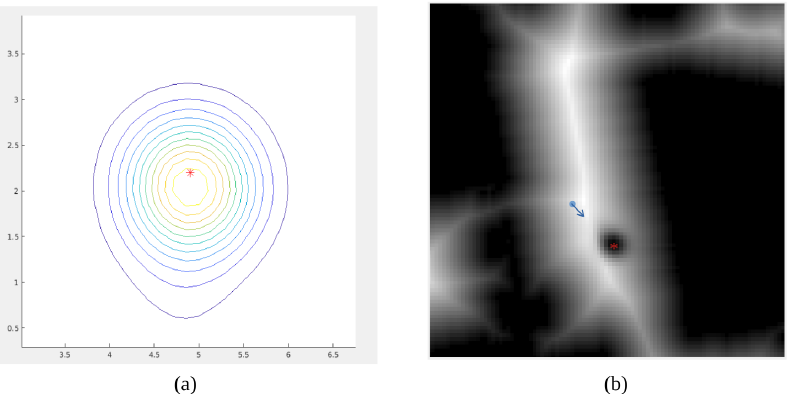
Figure 25. Detection and modeling of a person: ( a ) Gaussian model, in meters, defined in the robot reference frame, ( b ) inclusion of the Gaussian model in the velocity map using the map reference frame.